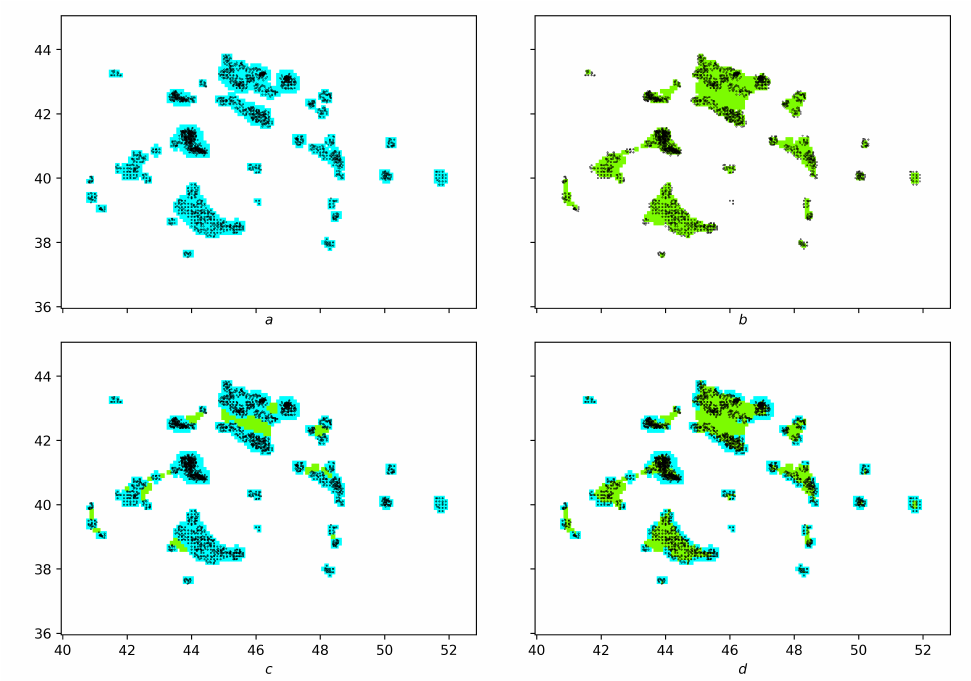
Figure 10. FCAZ zones constructed for the results from running the first stage of the SDPS algorithm on the array X (Figure 6b). ( a ) Extzones. ( b ) Int zones. ( c ) Int against the background of Ext. ( d ) Ext on the background of